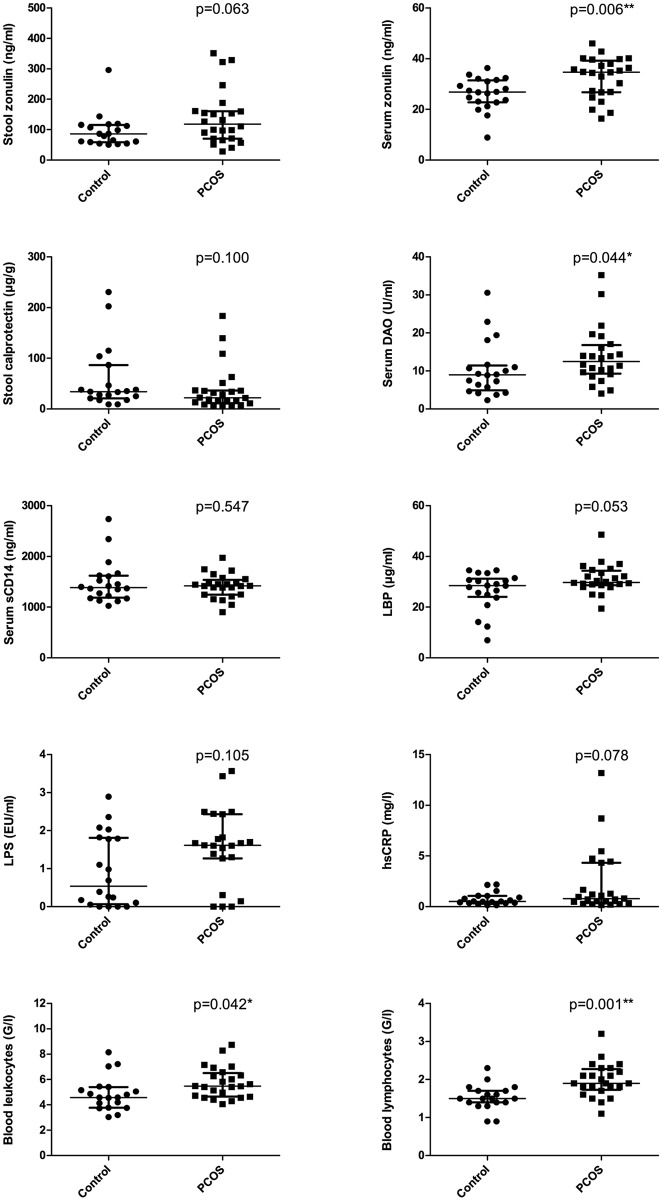
Markers of gut barrier integrity and inflammation in PCOS patients and controls.DAO: diamine oxidase, sCD14: soluble CD14 (endotoxin co-receptor), LBP: lipopolysaccharide binding protein, LPS: lipopolysaccharide (= endotoxin), hsCRP: high-sensitivity C-reactive protein. Dots represent individual study subjects. Bars represent median and IQR.